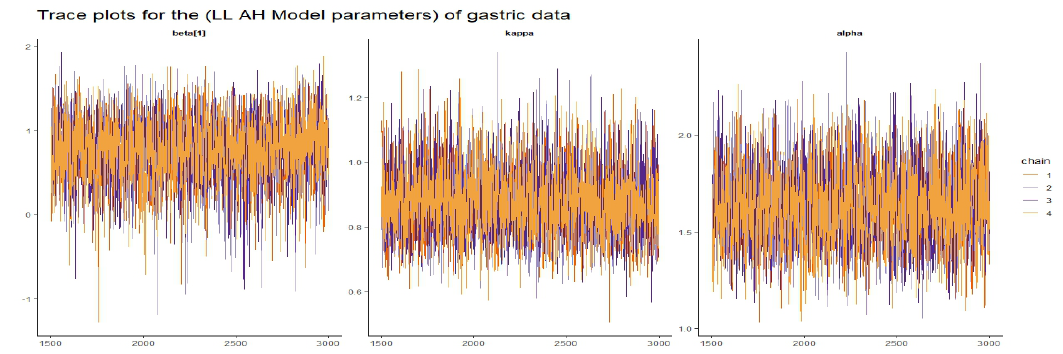
Figure 6. The GLL–AFT model posterior parameters trace plots of the gastric cancer data.